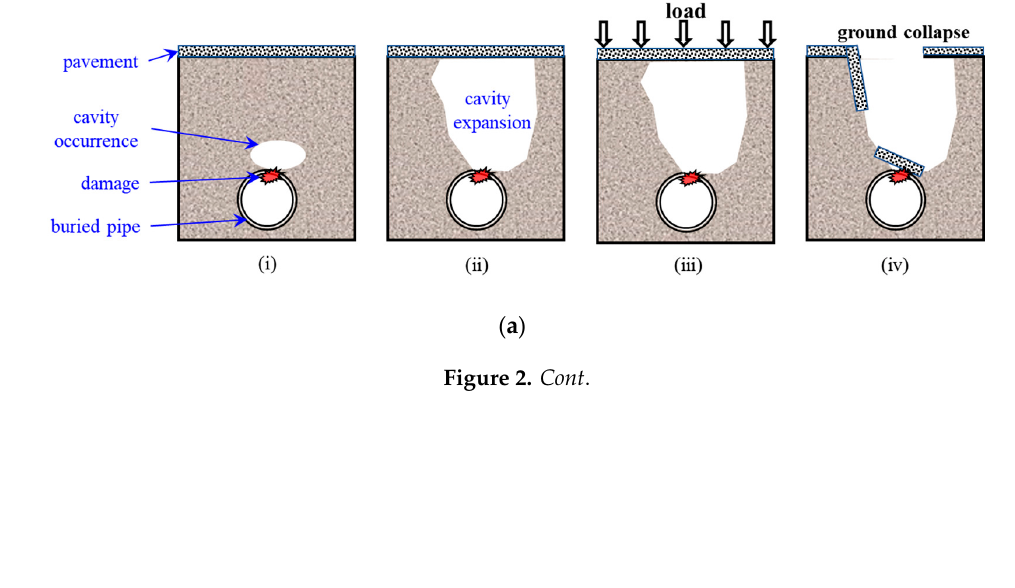
Figure 1. Concrete mat: ( a ) composition of a concrete mat; ( b ) field application example.